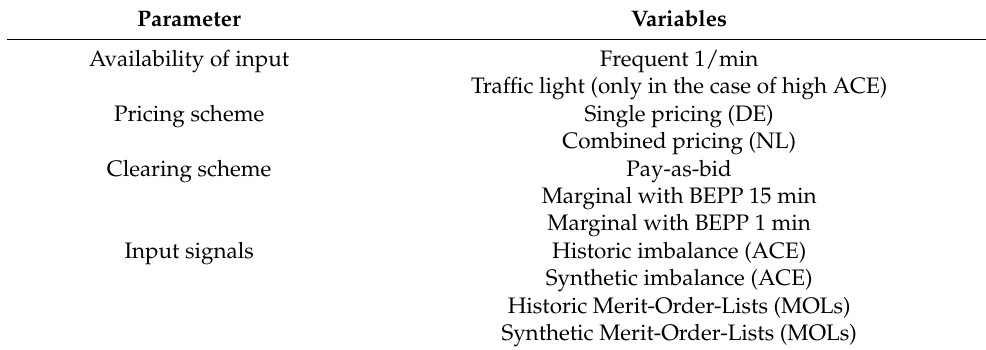
Table 1. Overview of market design